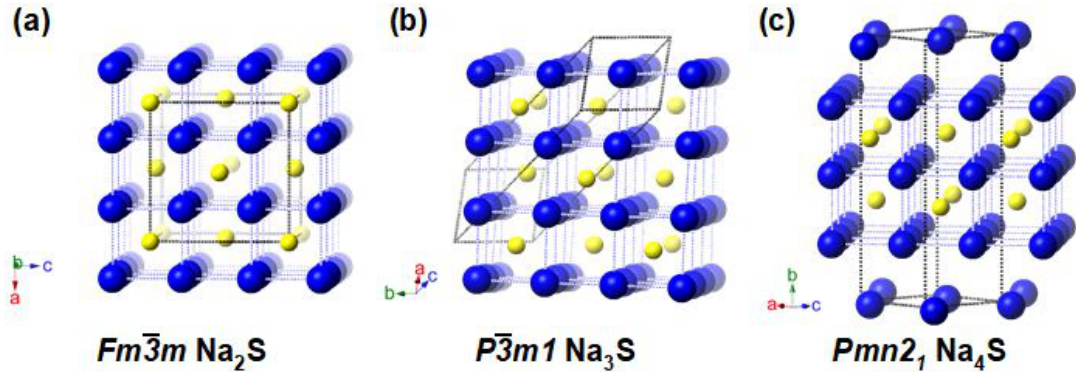
Figure 5. Crystal structures of ( a ) Fm ¯3 m -Na 2 S, ( b ) P ¯3 m 1-Na 3 S and ( c ) Pmn 2 1 -Na 4 S phases at 0 GPa. Sodium atoms are colored blue, and sulfur atoms are yellow.